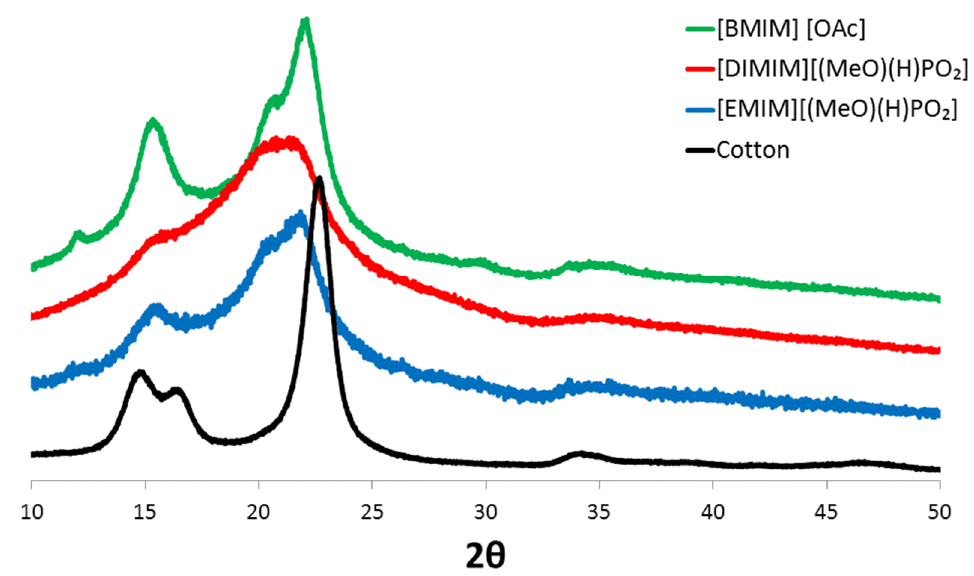
Figure 6. XRD spectra of raw cotton and cellulose dissolved and regenerated using [DIMIM][(MeO)(H)PO 2 ], [EMIM][(MeO)(H)PO 2 ] and [BMIM] [OAc] (cotton fiber content in ionic liquids = 5 wt% for phosphonate-based ILs and 10 wt% for [BMIM] [OAc]).